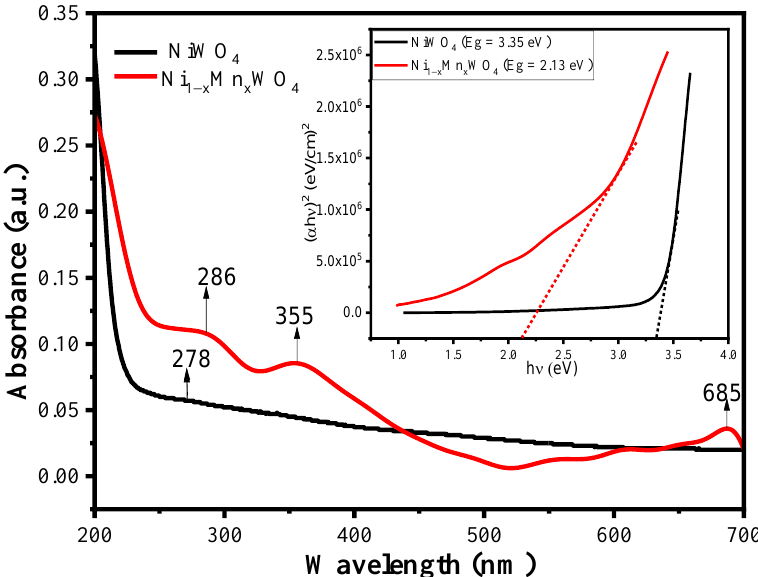
Figure 3. UV-Vis spectra of NiWO 4 (black line) and Ni 1 − x Mn x WO 4 NC (red line) with inset Tauc’s plot for calculating energy bandgap.